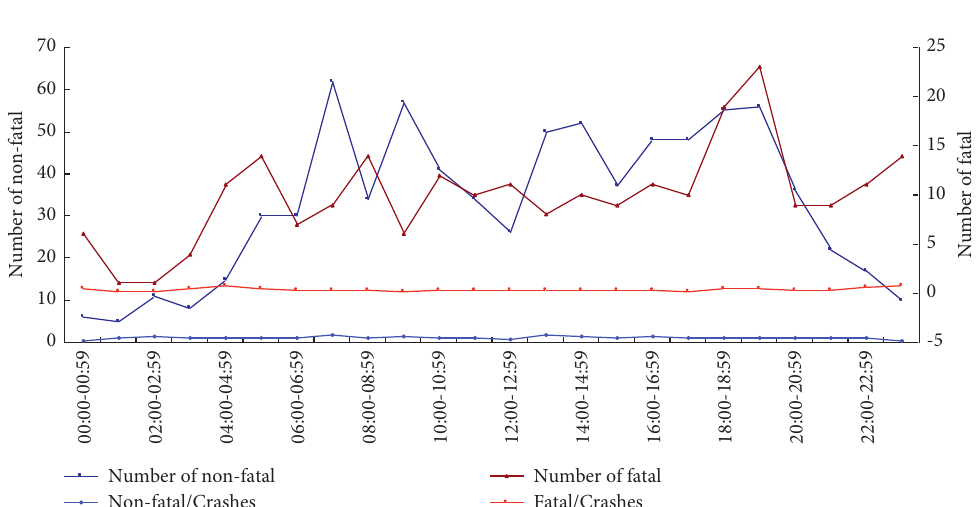
Figure 4: 24-hour time distribution of the number of casualties in traffic